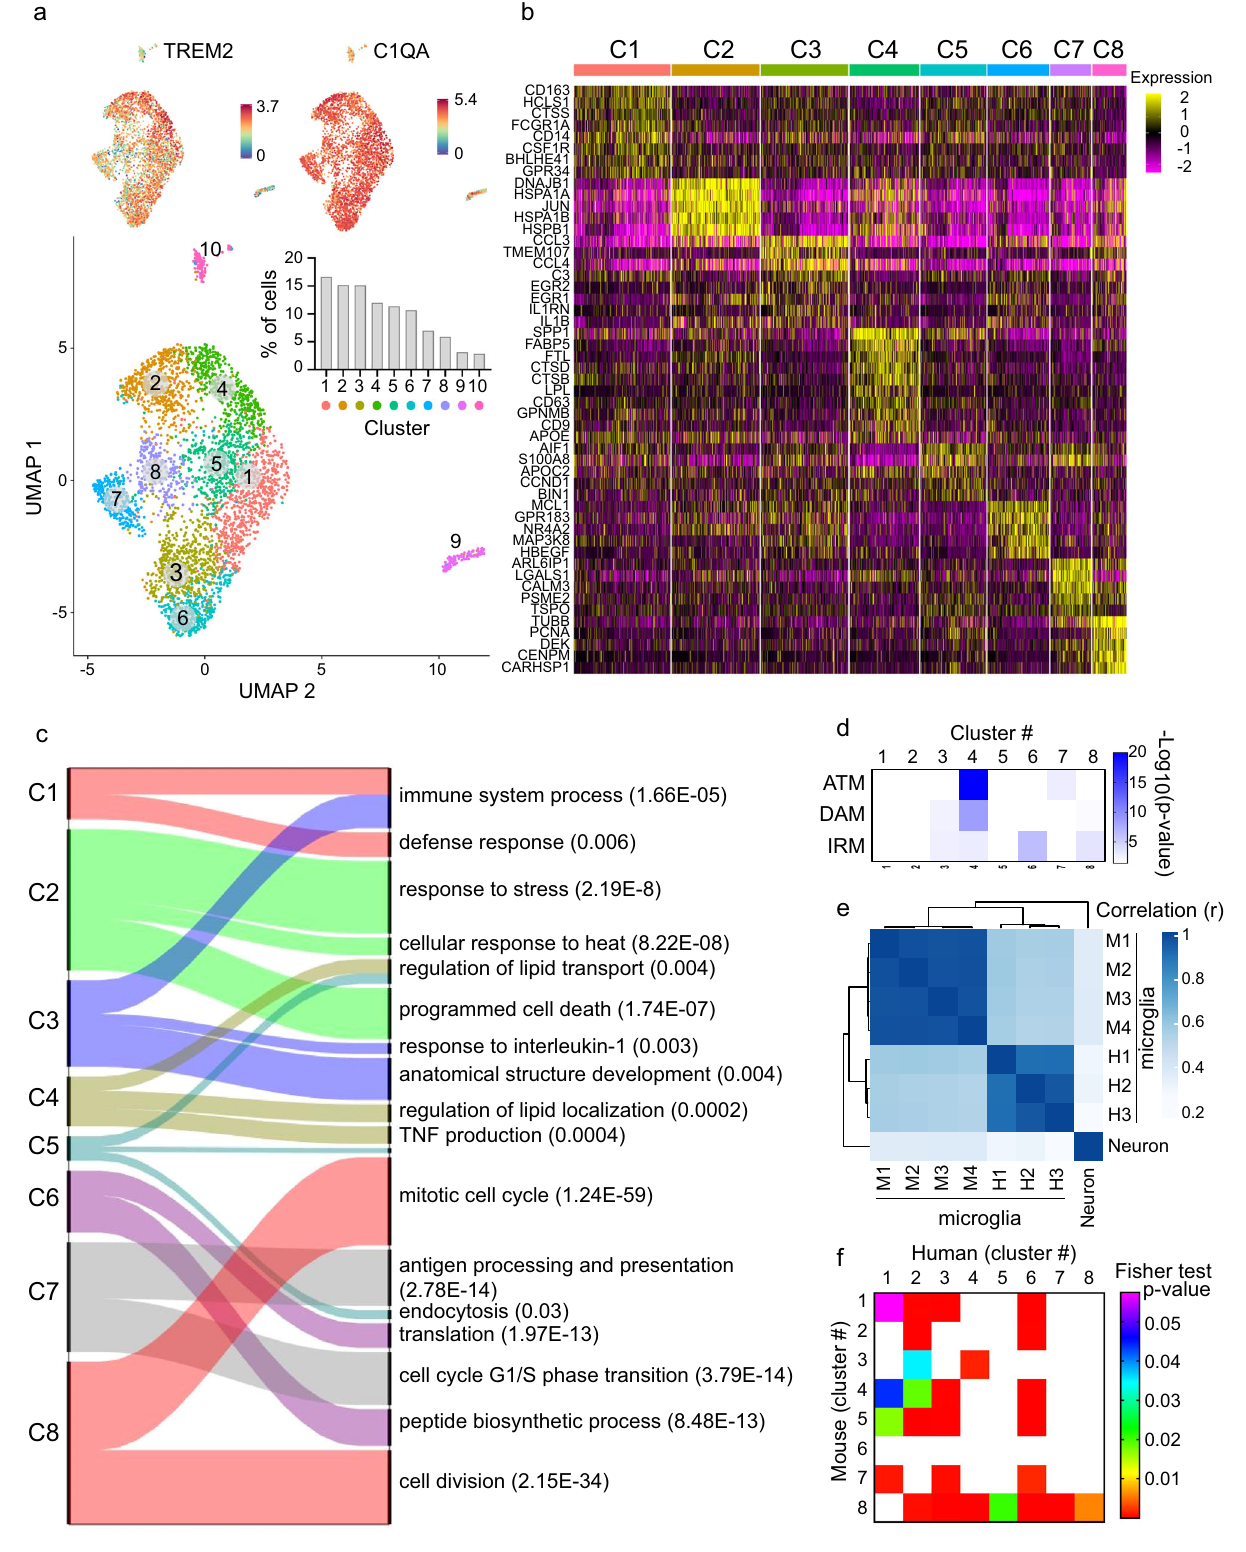
Data 9). In an analysis of common genes upregulated in the spinal cord and brain microglia clusters, we note that spinal cord microglia cluster 3 shows the greatest similarity with brain microglia clusters while little overlap between spinal cord clusters 7 and 8 and brain microglia clusters was observed, suggesting the existence of unique microglia subsets in the human spinal